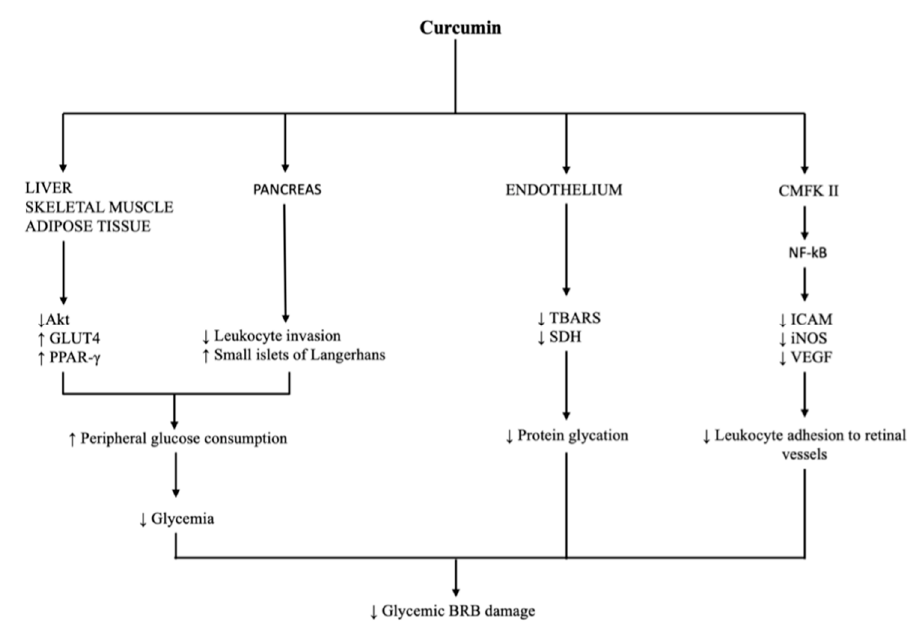
Figure 3. Diagram reviewing options to enhance curcumin delivery. Up arrow stands for augmentation, down arrow stands for reduction.